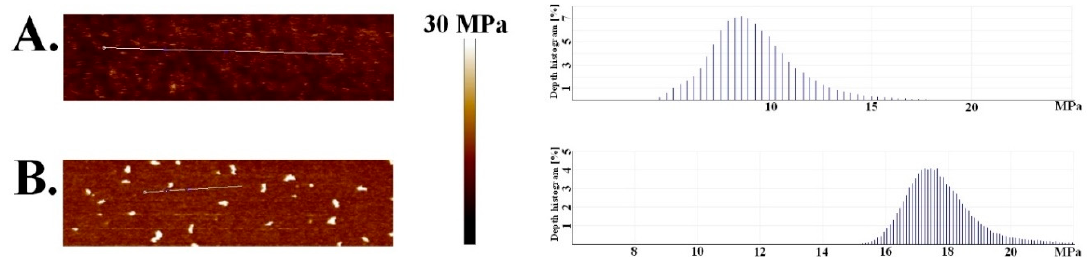
Figure 3. Quantitative nanomechanical mapping (QNM) measurements of poly(APTAC) ( A ) and poly(APTAC)+SPIONs ( B ) with the corresponding bearing analysis histograms.